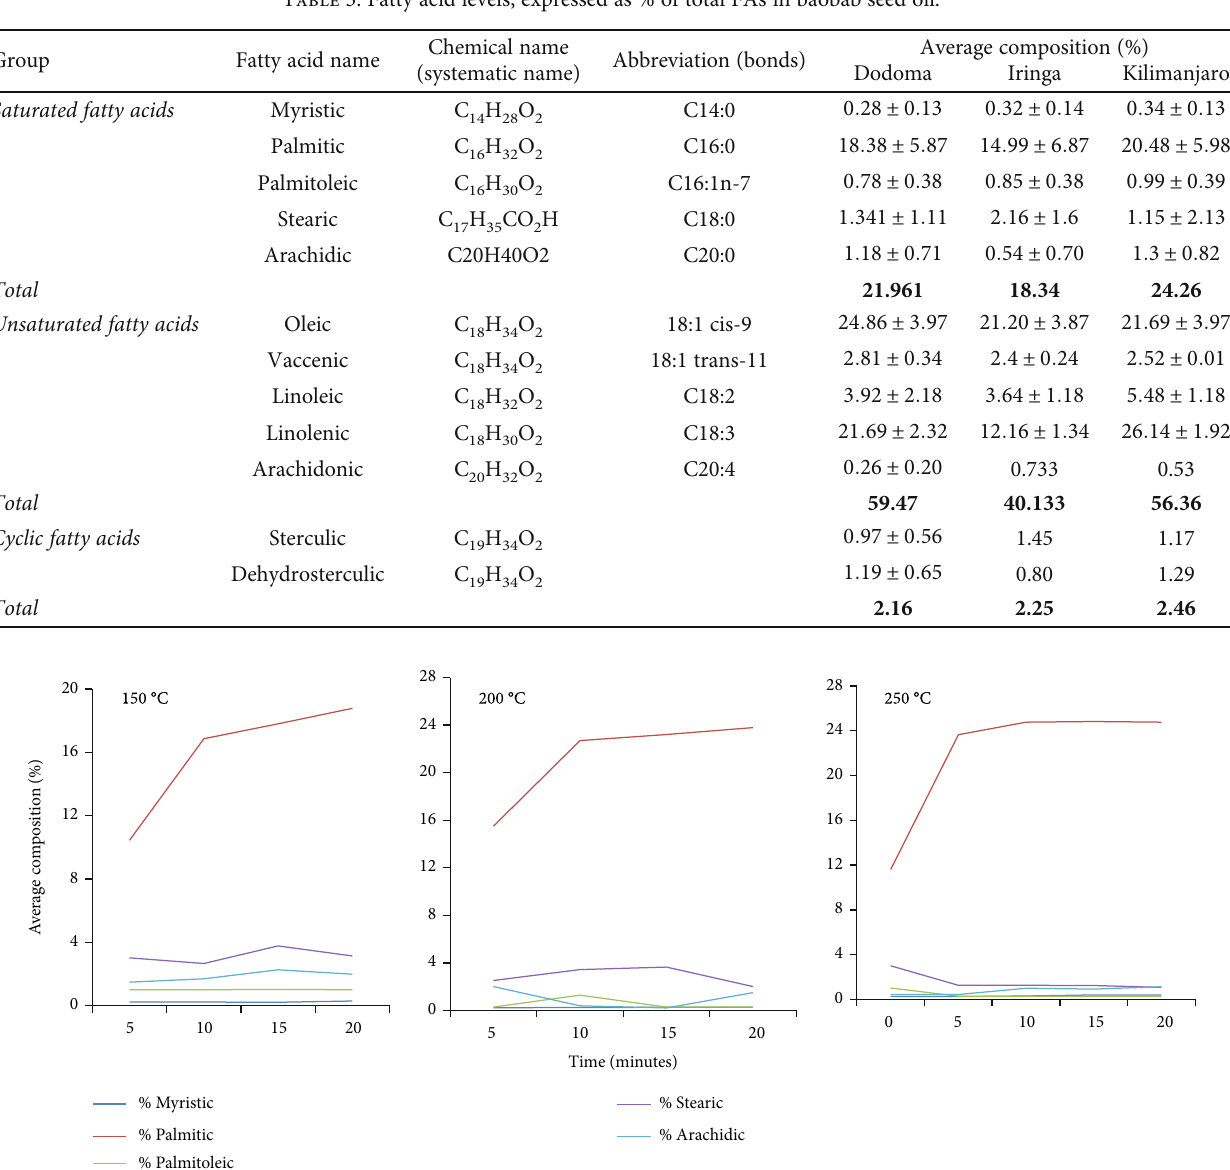
Figure 2: Percentage of saturated fatty acid compositions with a variation of time and